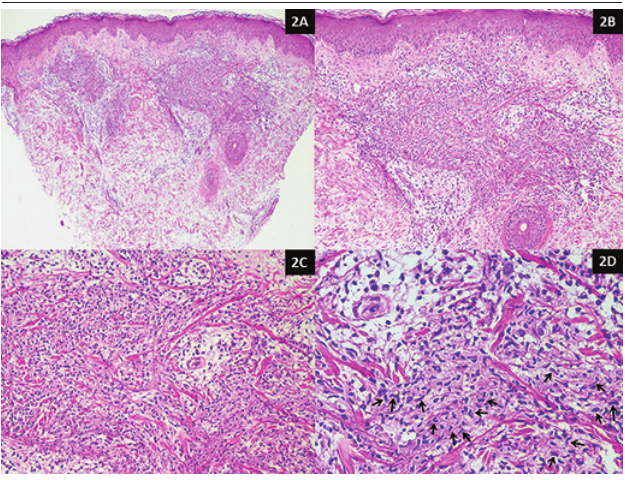
figurE 2 − 2A) photomicrograph of skin biopsy showing lymphohistiocytic inflammatory infiltrate between the connective bundles of the reticular dermis, without the presence of caseous necrosis, (HE, 20×); 2B) reticular dermis with lymphohistiocytic infiltrate (HE, 40×); 2C) detail to lymphohistiocytic infiltrate between the dermal connective bundles, without caseous necrosis (HE, 100×); 2D) the arrows indicate some epithelioid histiocytes (HE, 400×) HE: hematoxylin and